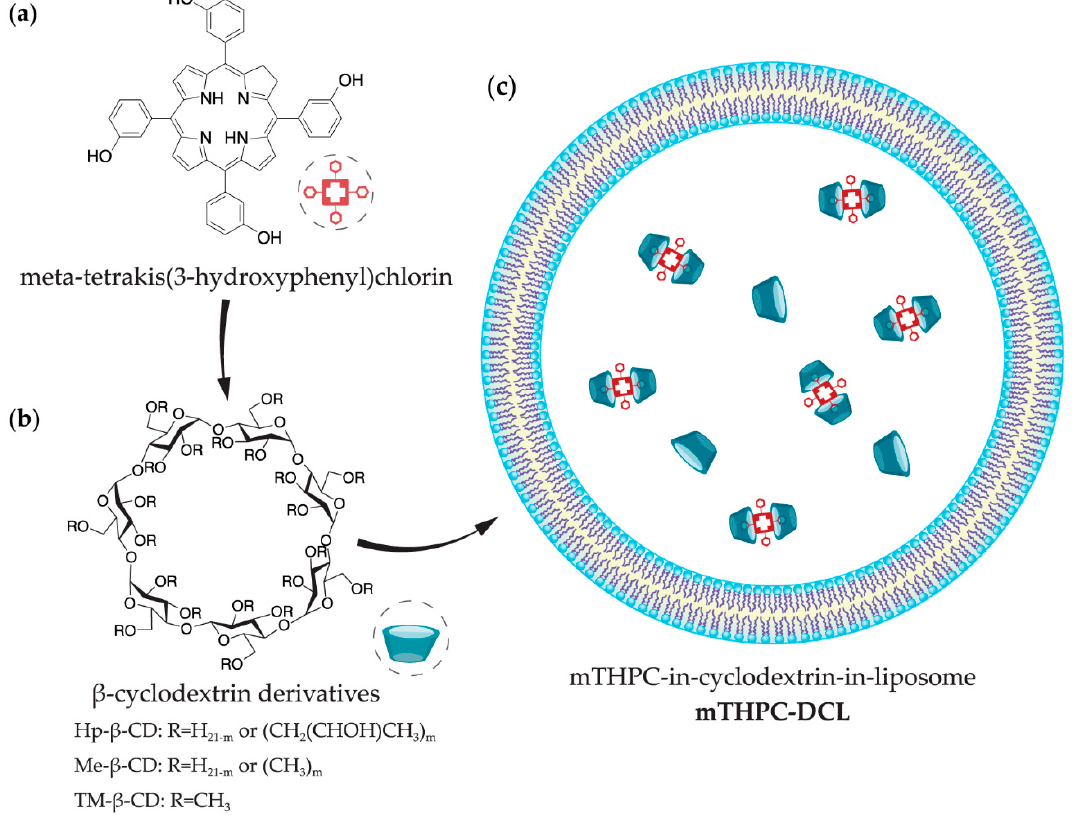
Scheme β -cyclodextrin ( β -CD) derivatives, and ( c ) drug-in-cyclodextrin-in-liposome (DCL) nanoconstruct.